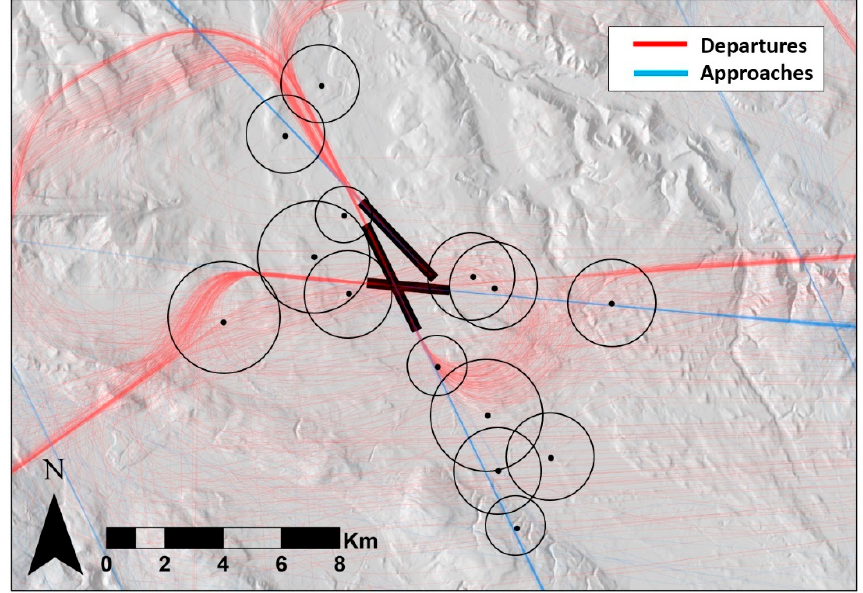
Figure 1. Noise monitoring terminals (NMT) in close range to ZRH with all flight trajectories used for this study, colored by procedure. The black circles around each terminal represent spatial gates, which the flight trajectories have to penetrate to be considered (basemap: swissALTI3D LV95, swisstopo; source: Federal Office of Topography).